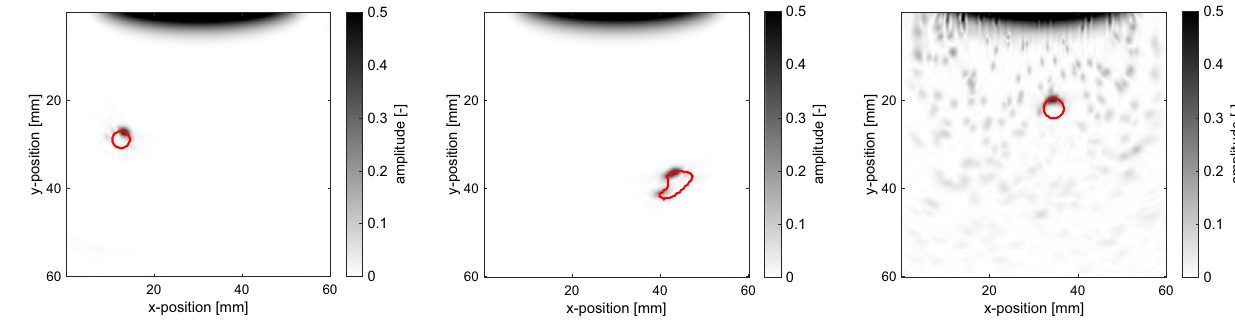
Fig. 2 TFM images of the three datasets with the boundary of the defect marked in red. Left: round defects. Middle: complicated defect shapes in a homogeneous medium. Right: round defects in a medium with microstructure noise